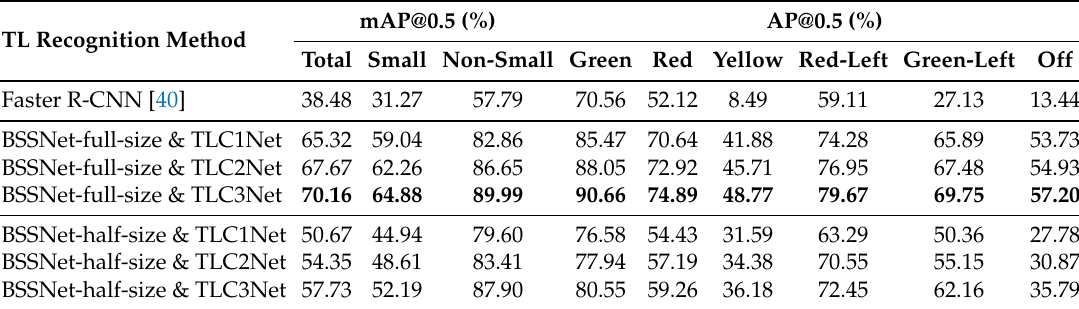
Table 4. TL recognition performances (mAP@0.5 and AP@0.5) on test